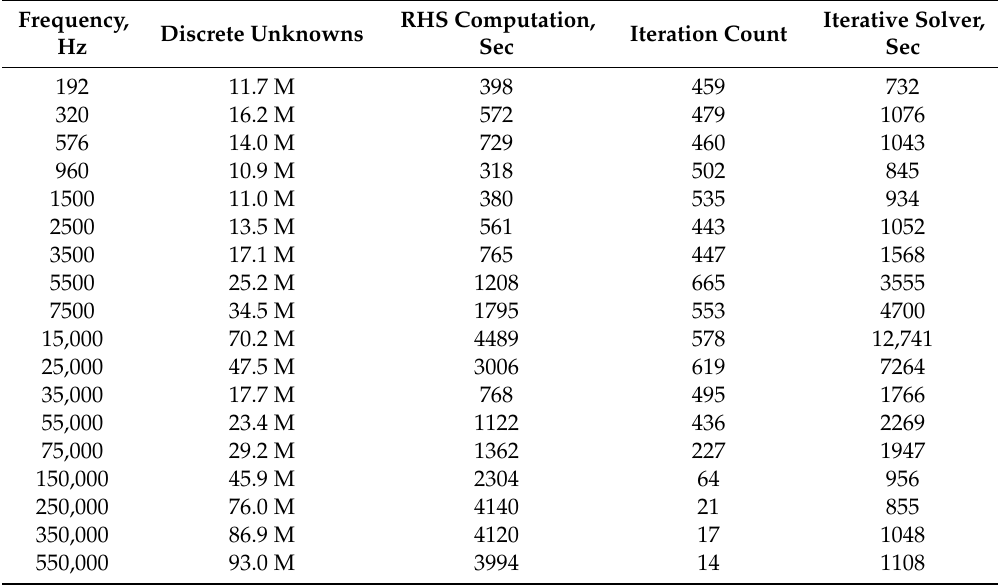
Table 6. Performance of the forward simulation with OpenMP parallelization on 24